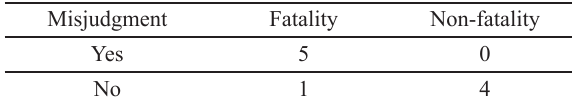
Table 3. Example statistics for Fisher’s exact test